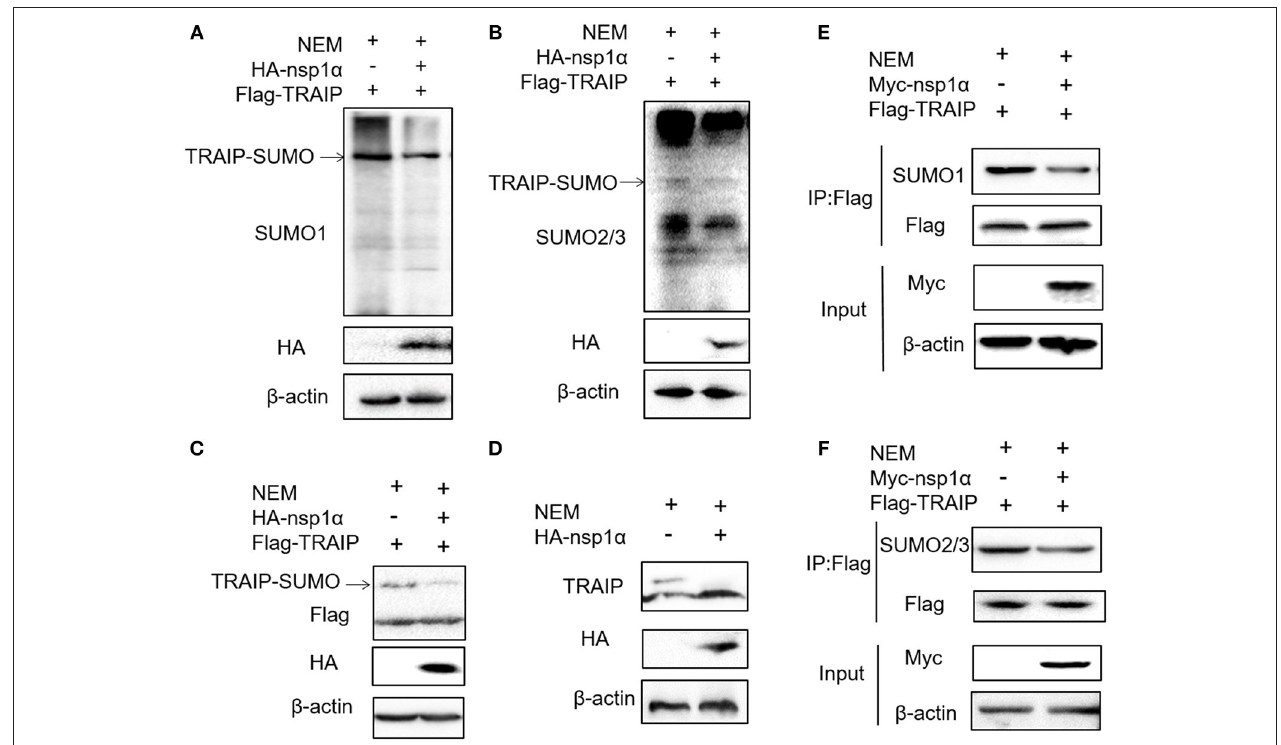
FIGURE 4 | Nsp1 α removed SUMO-modification of TRAIP. HEK 293T cells were transfected with HA-nsp1 α and Flag-TRAIP, and lyzed in RIPA buffer containing desumoylation protease inhibitor N-Ethylmaleimide [NEM] inhibition of deSUMOylation of TRAIP. The effect of nsp1 α on TRAIP SUMO modification was detected using SUMO1 antibody (A) or SUMO2/3 antibody (B) . (C) HEK 293T cells were co-transfected with HA-nsp1 α and Flag-TRAIP, and the effect of nsp1 α on exogenous TRAIP SUMO-modification was detected by Western blotting. (D) HEK 293T cells were transfected with HA-nsp1 α or vector and the effect of nsp1